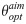
Experimental 2 design.Participants experienced a complex reinforcement landscape where they were initially positioned in the ‘valley’ between a steep and shallow slope. Participants experienced a reinforcement landscape where the steep slope rose in the A) clockwise direction (CW) or C) counterclockwise (CCW) direction. These reinforcement landscapes define the probability of reward (y-axis) as a function of reach angle (x-axis). Reach angle is normalized to baseline reach behaviour and is expressed as a z-score. B) and D) define the probability of reward (y-axis) given intended aim (x-axis) for the steep clockwise and steep counterclockwise reinforcement landscapes, respectively. In both these figures, θoptaim and the corresponding dashed vertical line correspond to the optimal intended reach aim that maximizes reward. We predicted that participants experiencing the steep clockwise reinforcement landscape to adjust their aim in the clockwise direction. Similarly, we expected that those experiencing the steep counterclockwise reinforcement landscape to adjust their aim in the counterclockwise direction.